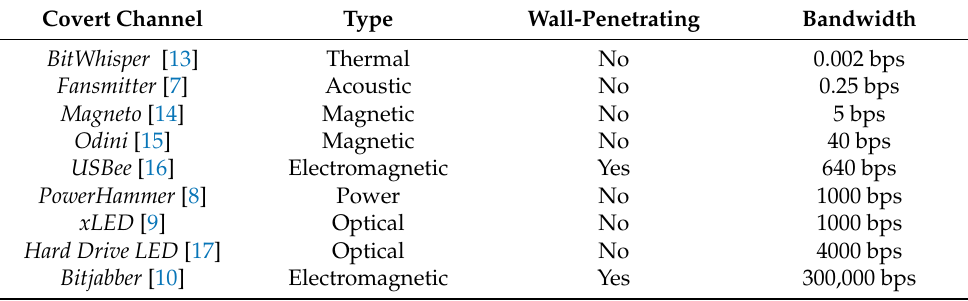
Table 1. Comparison of existing physical covert